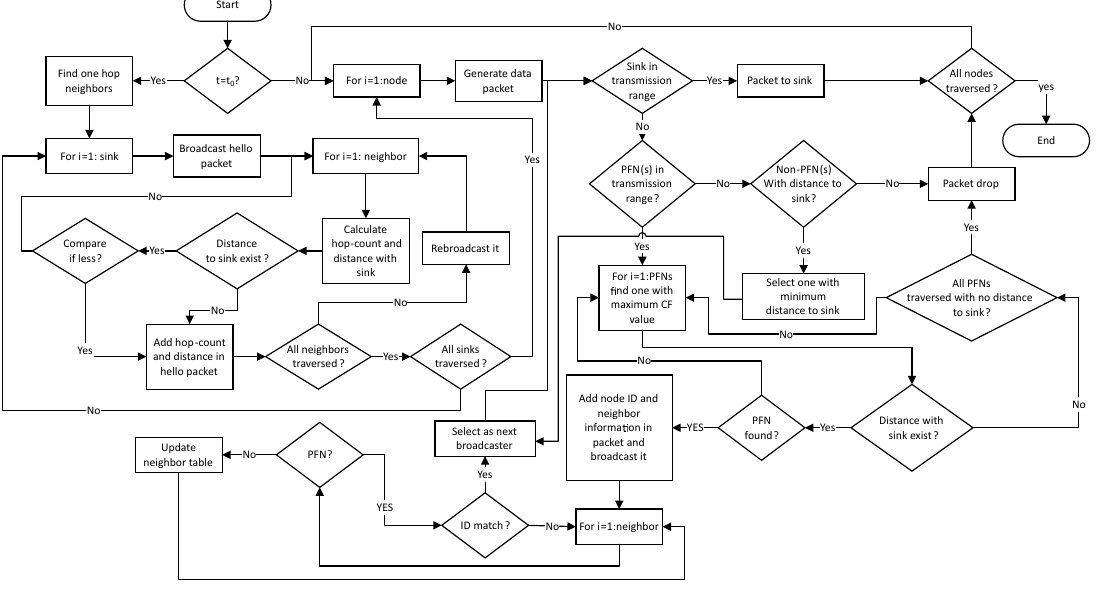
Figure 3. The Re-intar: flow